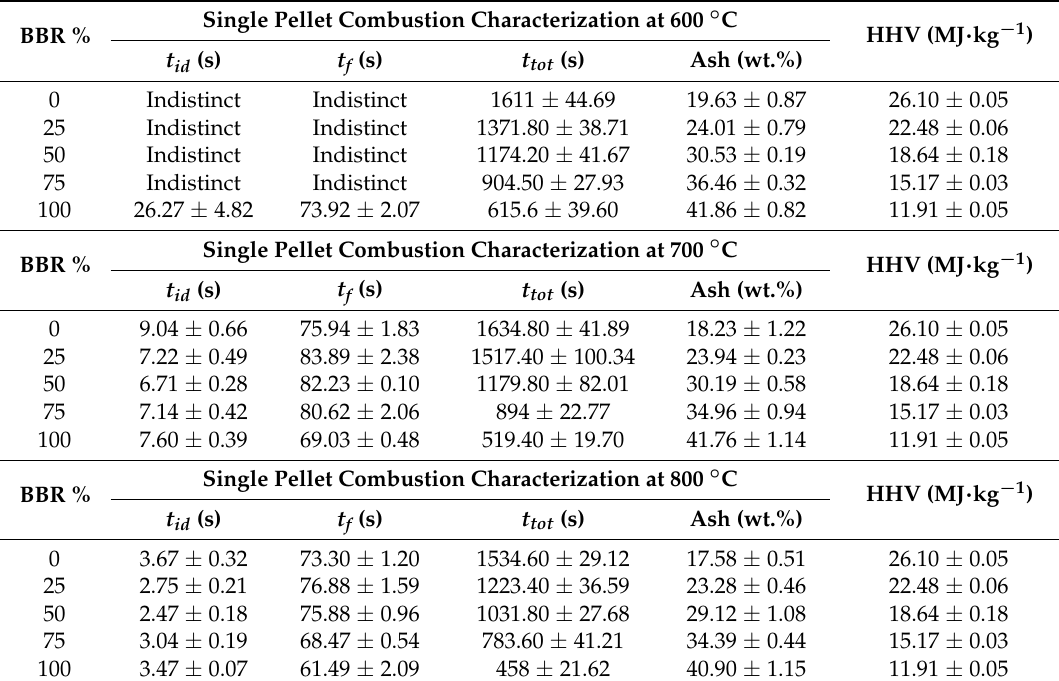
Table 6. Single-pellet combustion characterization for various sludge-coal ratios (BBR = SSR = 100%: pure sludge).